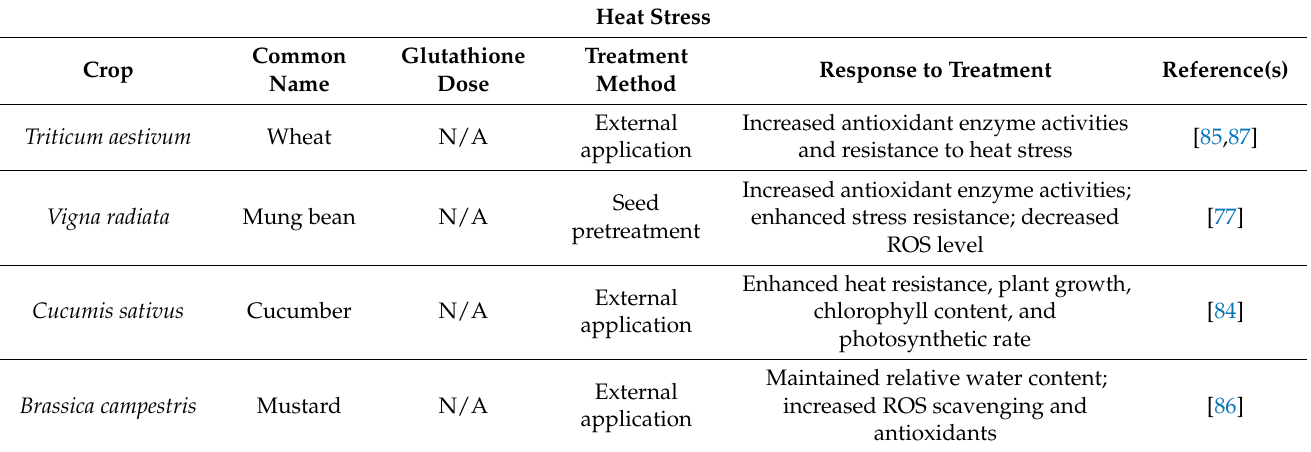
Table 8. Physiological responses of various crops to glutathione treatment against heat stress.